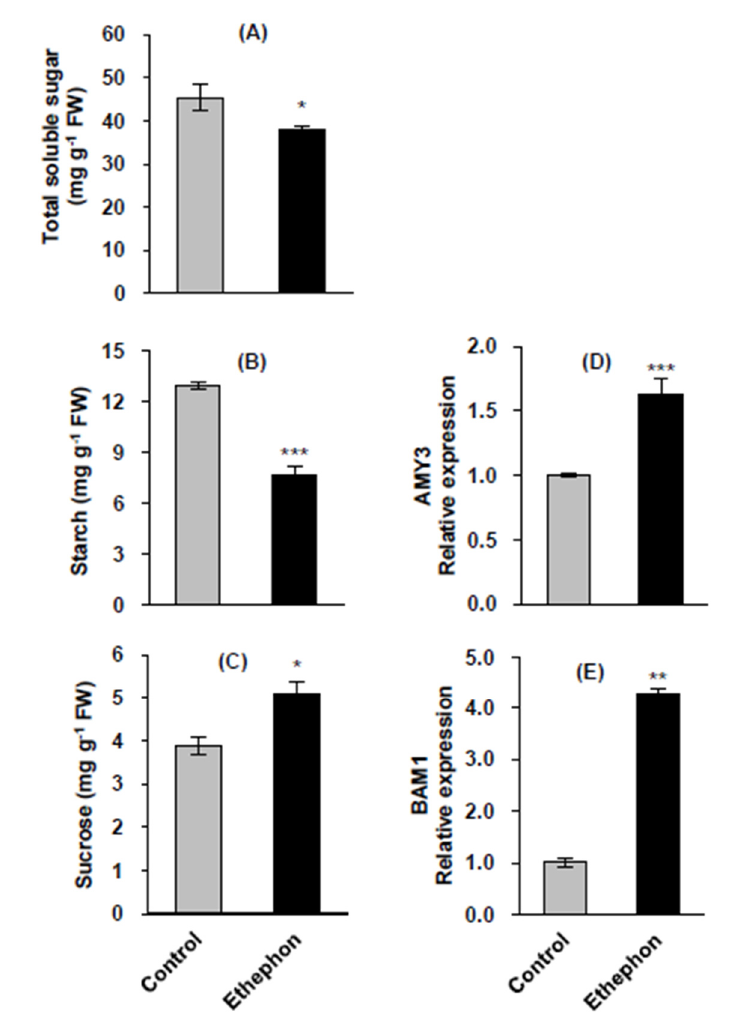
Figure 3. Total soluble sugar ( A ), starch ( B ), and sucrose contents ( C ), and expression of the starch degradation-related genes AMY3 ( D ) and BAM1 ( E ) in mature leaves in control or ethephon-treated plants for 10 days. Data are presented as means ± SE ( n = 3). The qRT-PCR was performed in duplicate for each of the three independent biological samples. Significant differences between treatments are represented by * P < 0.05, ** P < 0.01, *** P < 0.001.